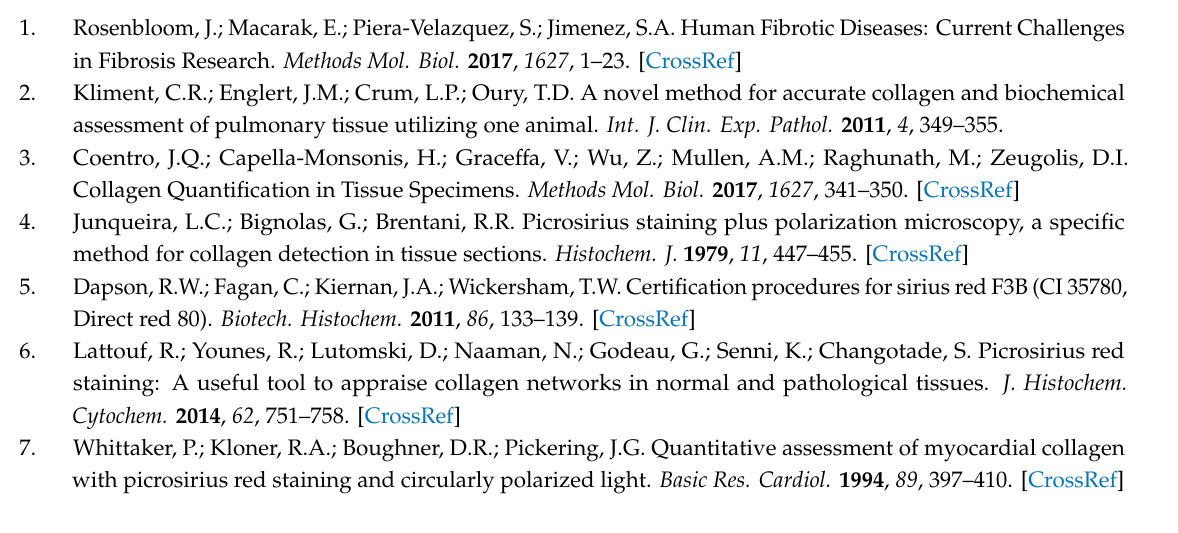
Supplementary Material 1: Computer assisted organ-specific definition of the regions-of-interest. Supplementary Material 2: Detection filters and threshold determination for the RGB-based or the PSR-optimized methods. Supplementary Material 3: RGB-based and the PSR-optimized methods used for multi-organ comparison in liver, lung, and kidney (illustration and correlation). Supplementary Material 4: Validation of the developed PSR-optimized method vs. previously described PSR-detection method on murine kidney